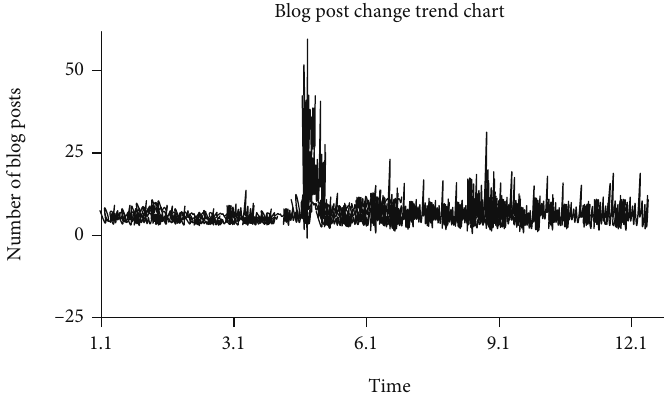
Figure 8: Research framework of the overall system.